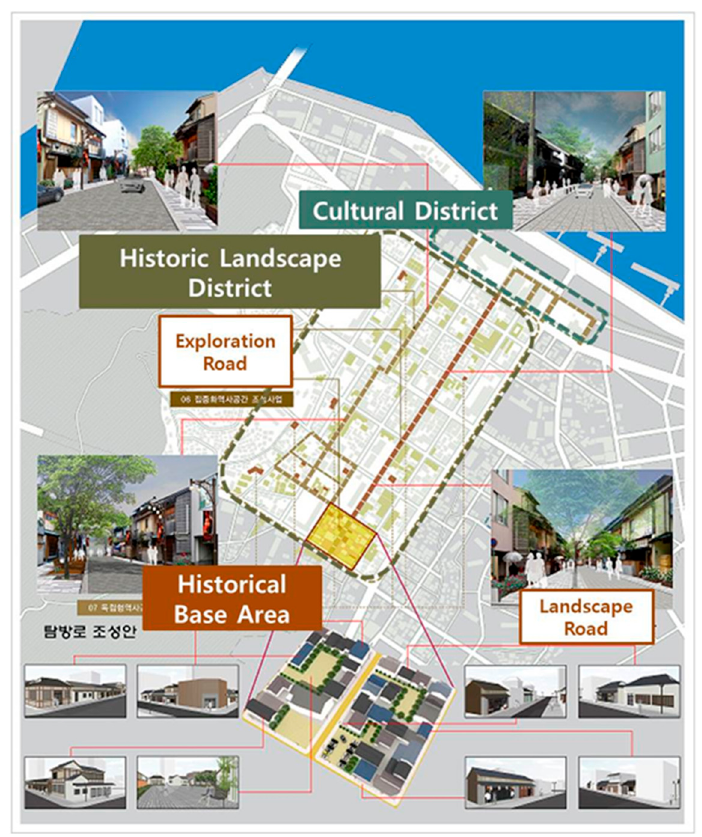
Figure 1. Project to create a modern cultural city, 2009–2019 [23].